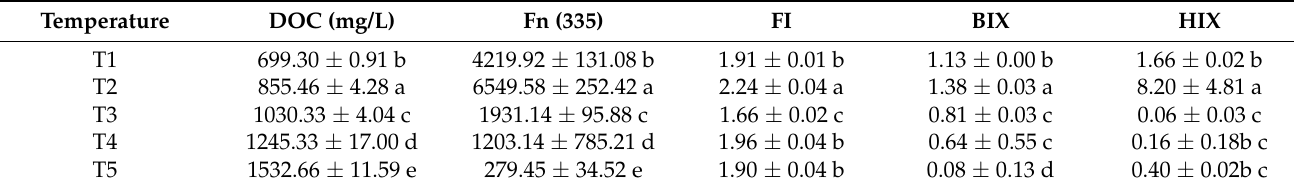
Table 1. Indices (Fn (335), HIX, FI, and BIX) and dissolved organic content of dissolved organic matter derived from pyroligneous acid at different temperature